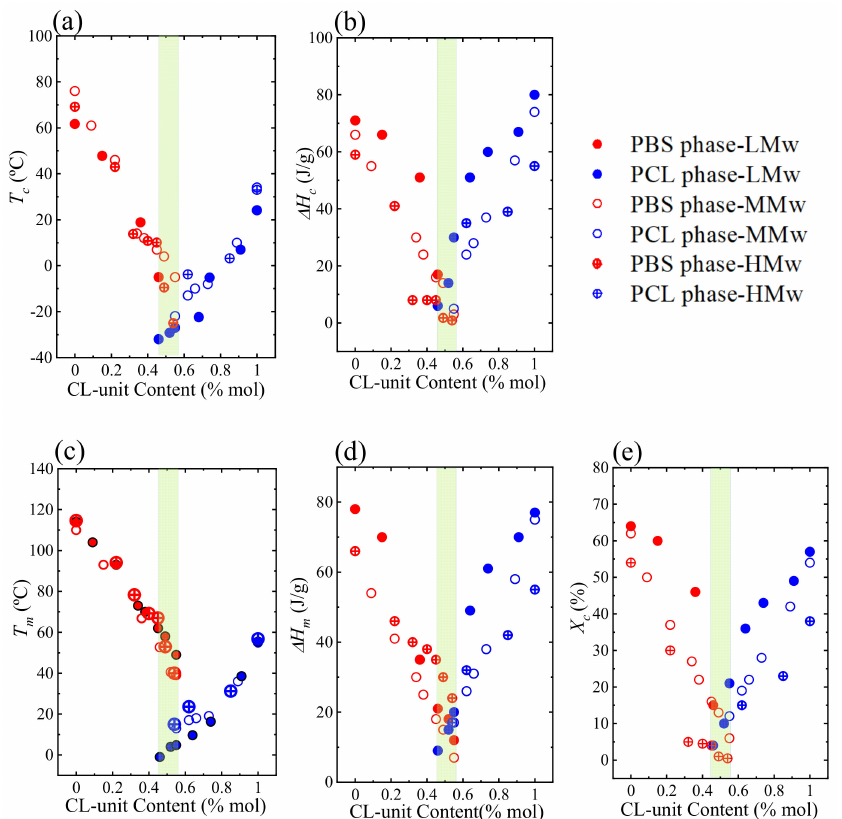
Figure 4. ( a ) Crystallization temperature ( T c ); ( b ) crystallization enthalpy ( ∆ H c ); ( c ) melting tempera- ture ( T m ); ( d ) melting enthalpy ( ∆ H m ); and ( e ) crystallization degree ( X c ) values of the three sets of copolyesters. The shaded composition range is the pseudo-eutectic